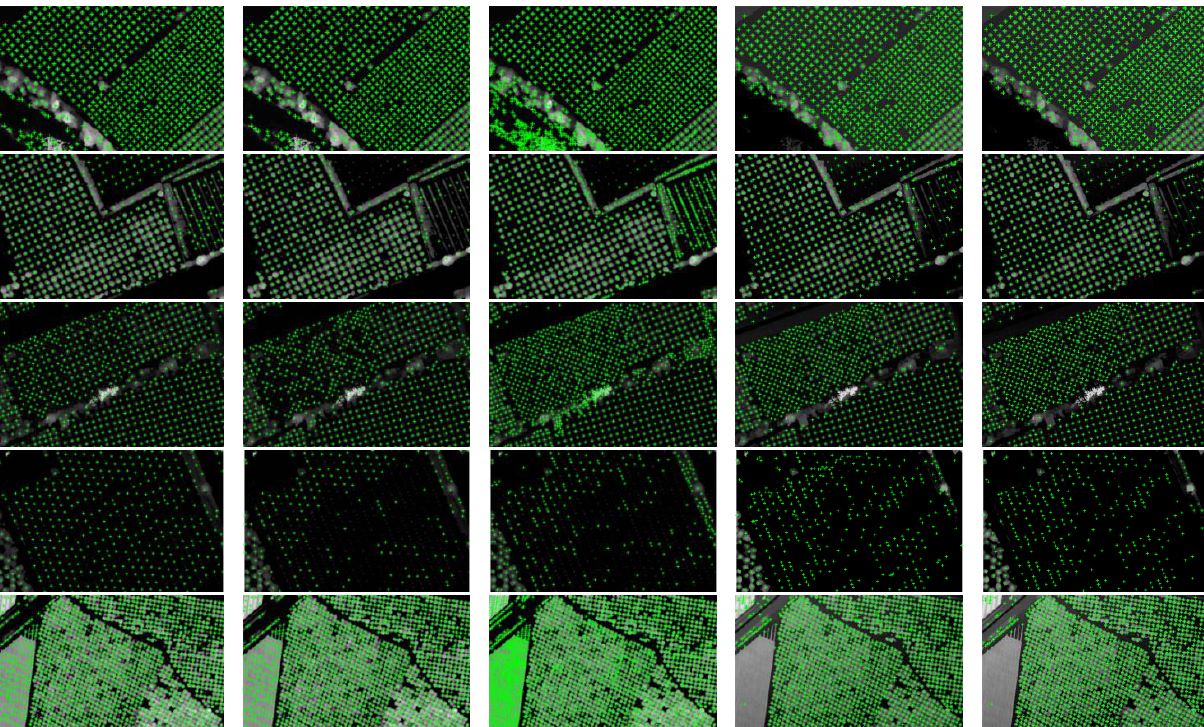
Figure 6. Detection results of the approaches. (first column) The results of the approach in (Popescu and Wynne, 2004), (second column) the results of the approach in (Swetnam and Falk, 2014), (third column) the results of the approach in (Dalponte et al., 2015), (fourth column) the results of the approach in (Ok and Ozdarici-Ok, 2017), and (fifth column) the results of the approach. The green “+” signs in each figure corresponds to a (citrus) tree (crown) location found by the approaches. Note that, nDSM is used as an input except for (Ok and Ozdarici-Ok, 2017) and the proposed approach; therefore, the brightness levels of the DSMs presented in the background of the last two columns are manually adjusted to approximately match the brightness levels of the nDSMs presented in the first three columns to improve the visual interpretability.